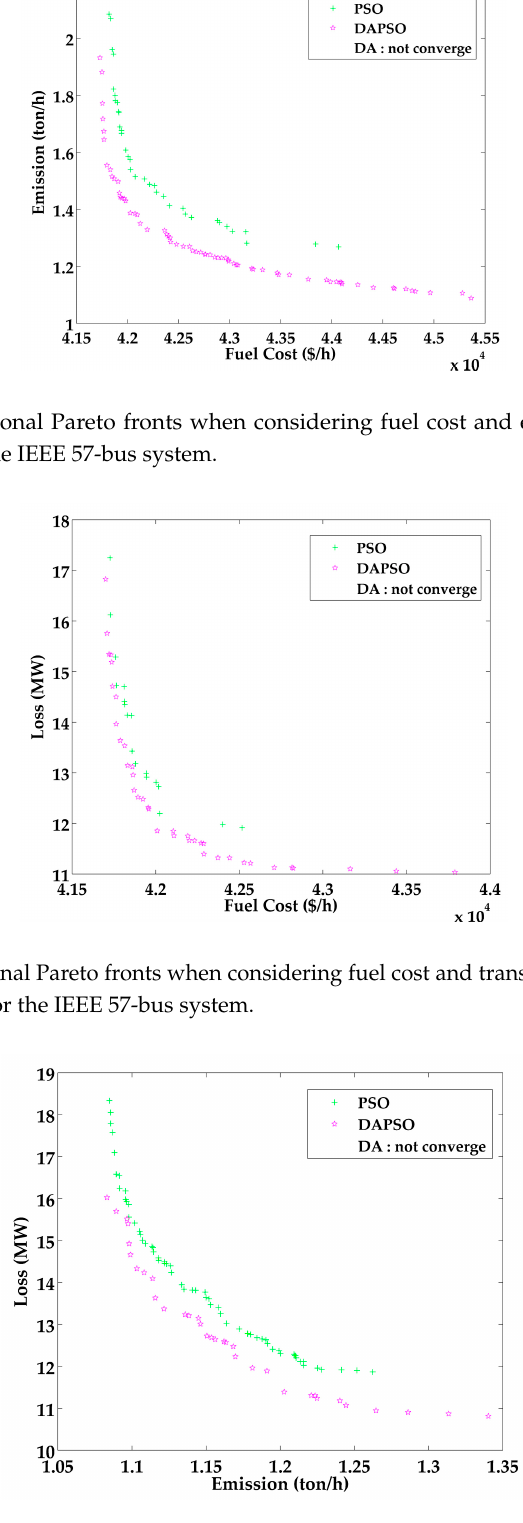
Figure 9. Three-dimensional Pareto fronts when considering fuel cost, emissions, and transmission losses as part of the objective function for the IEEE 57 -bus system.